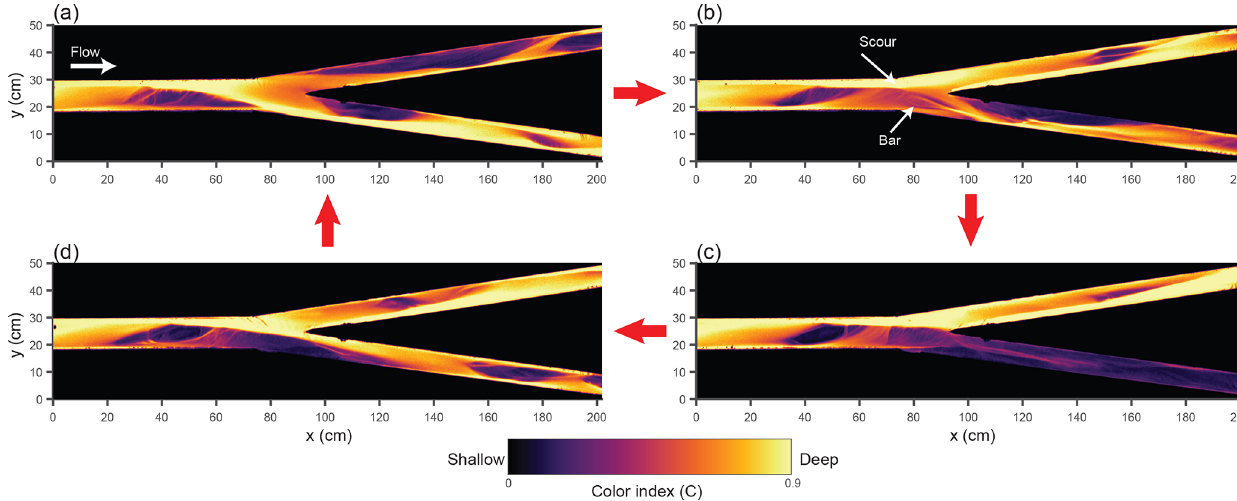
Figure 6. Color index C obtained from overhead images, illustrating the bypass dynamics observed in experiment 4. Images are taken at time (a) 1595min, (b) 1602min, (c) 1698min, and (d) 1707min. Corresponding values of (cid:49)Q are: (a) − 0 . 55, (b) 0 . 38, (c) 0 . 84, and (d) 0 .